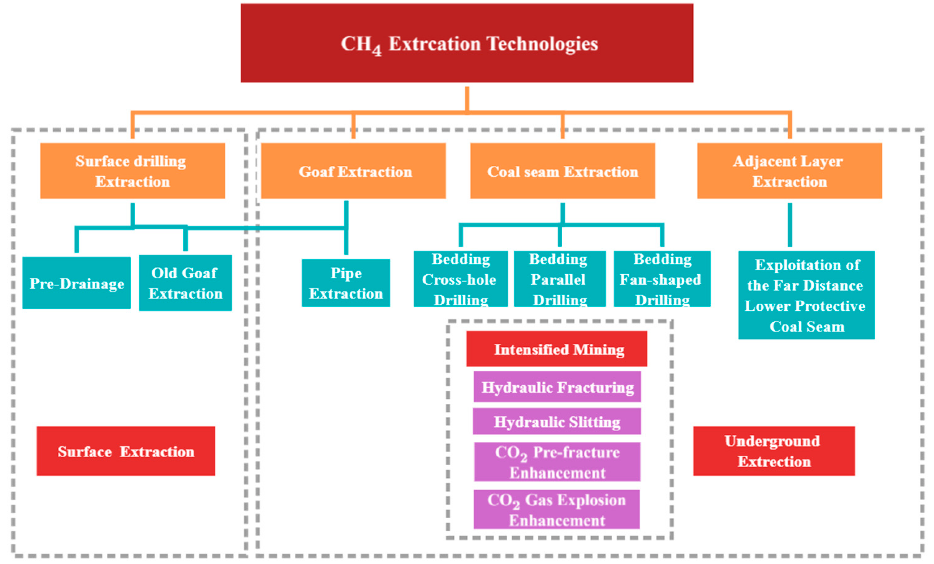
Figure 8. Coal mine CH 4 extraction technologies with promotion potential.